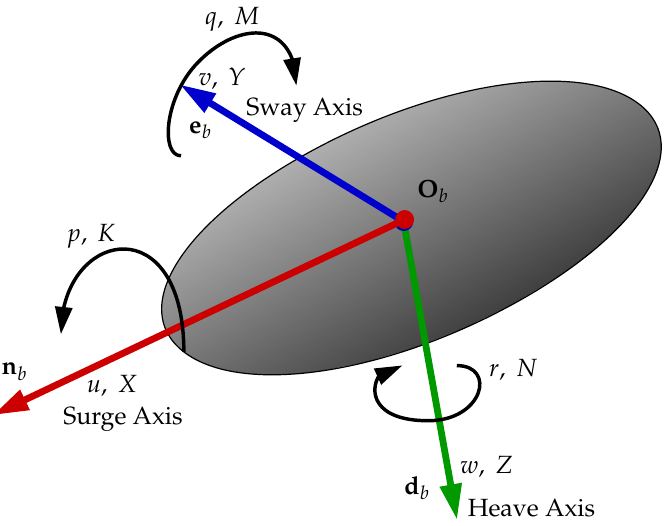
Figure 2. Definition of the body frame b of the vehicle. Note the components of v b and τττ b in each corresponding